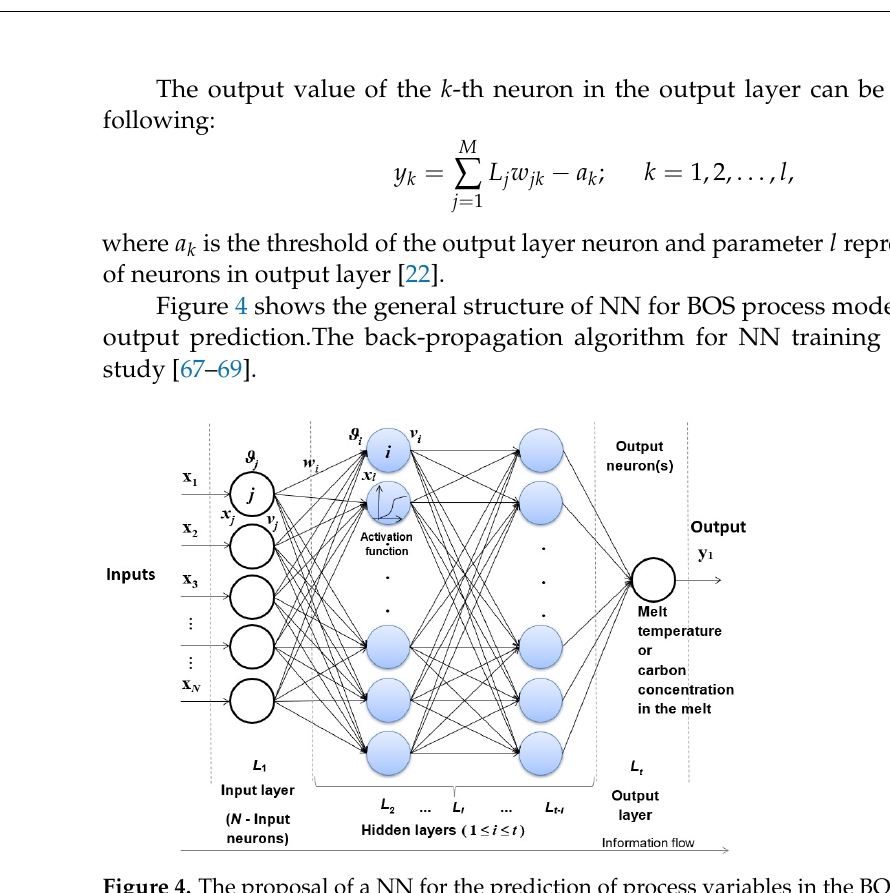
Figure 4. The proposal of a NN for the prediction of process variables in the